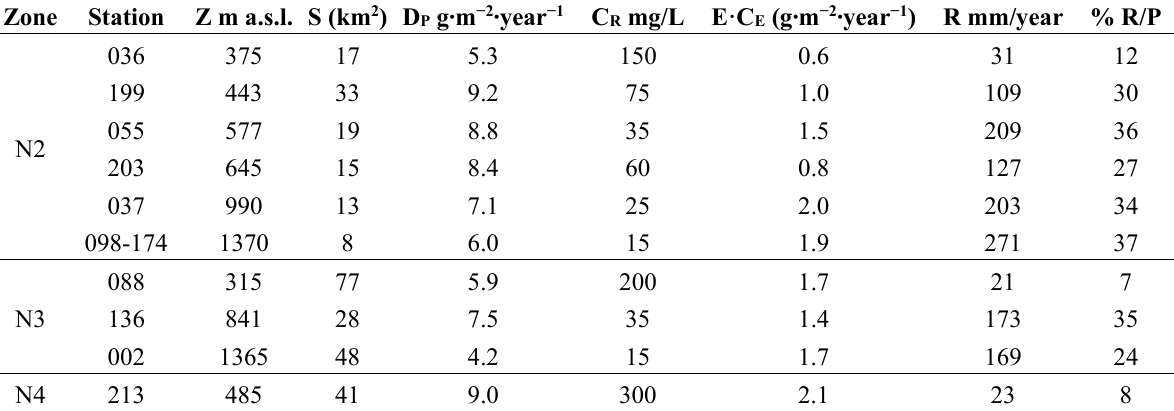
Figure 5. Chloride concentration (mg/L) isoline map in groundwater in 1997 using the data provided by the Water Council of Gran Canaria and the new data from the springs and galleries sampled in 2013. Table 4. Average recharge estimated by the chloride mass balance method in each collector. Z = elevation; S = area of influence per collector; D P = average deposition of atmospheric chloride during the study period; E = surface runoff; C R = chloride concentration in recharge water (groundwater); C E = chloride concentration in surface runoff water; R = estimated recharge; P =